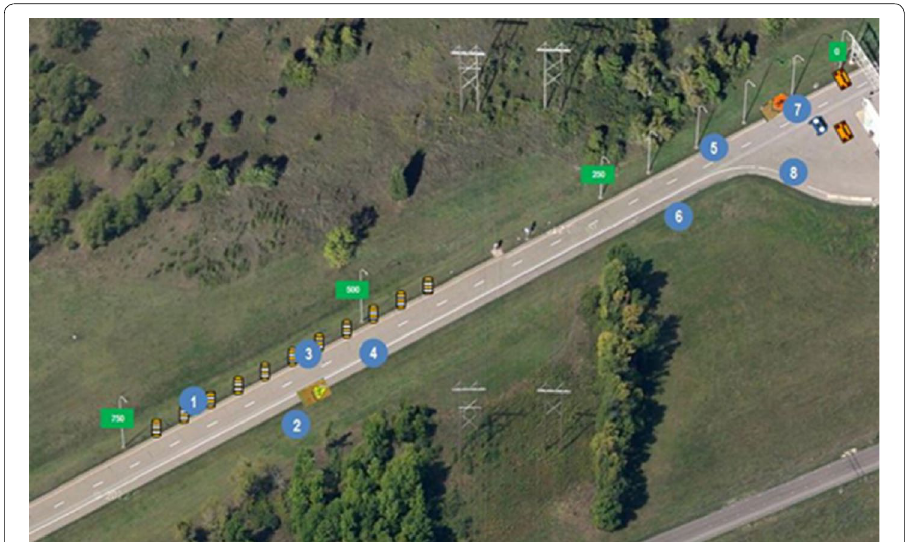
565 m, and 569 m from the trial starting location. Orange construction zone barrels were located between 362 and 466 meters, an SUV faced the observer at 574 m, fluorescent road worker signs were at 411 and 561 m, and two mock fire truck rear ends were at 580 and 587